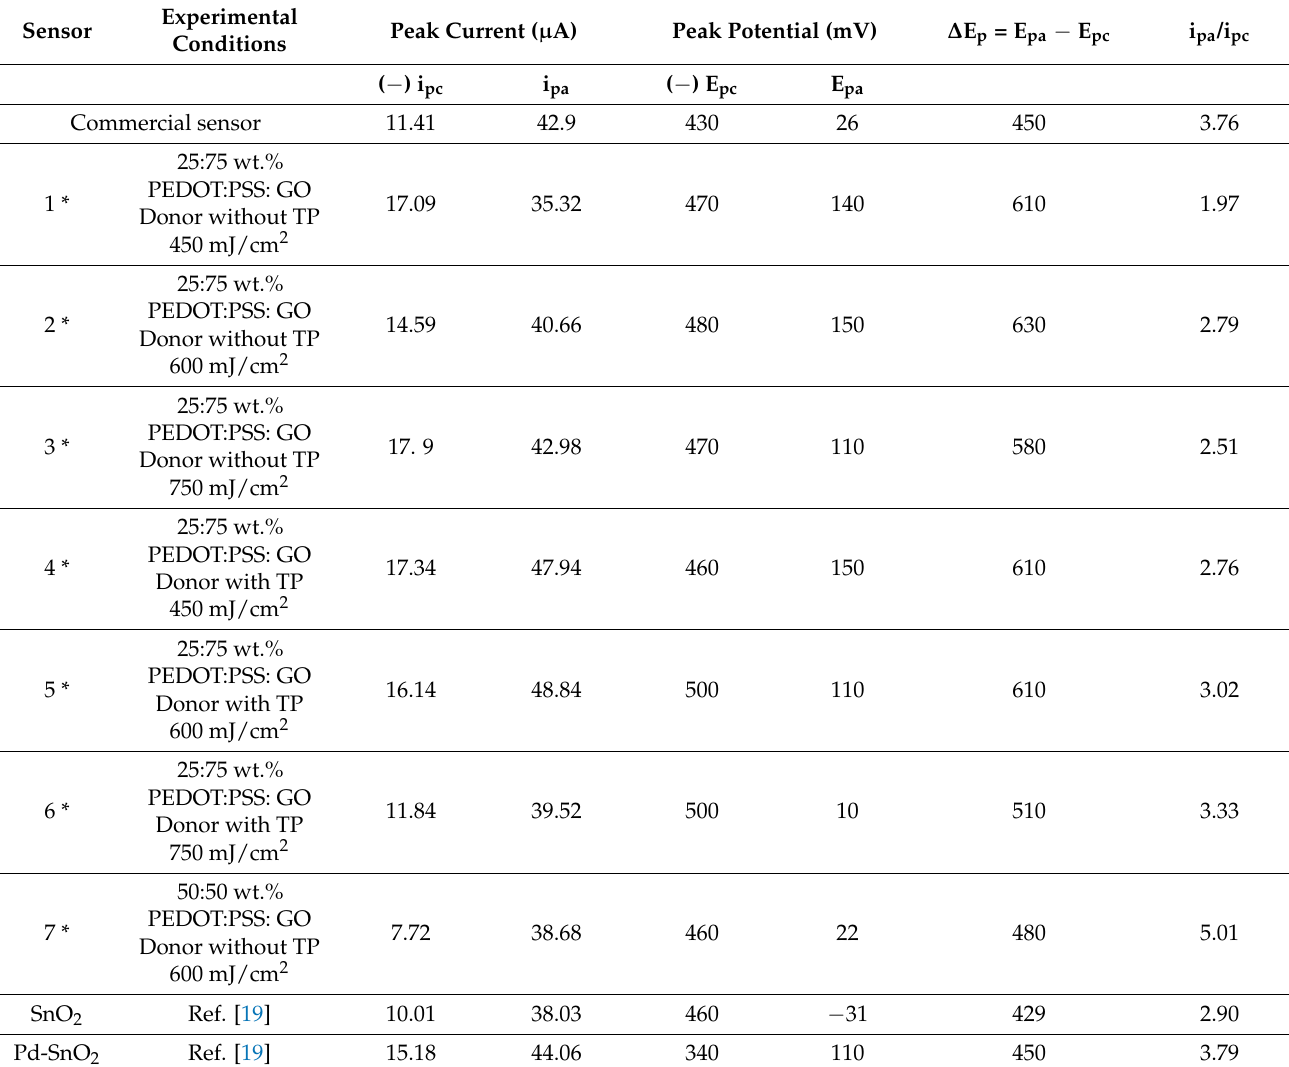
Table 1. Data gathered from the current vs potential plots obtained for the commercial working electrode and the LIFT fabricated working